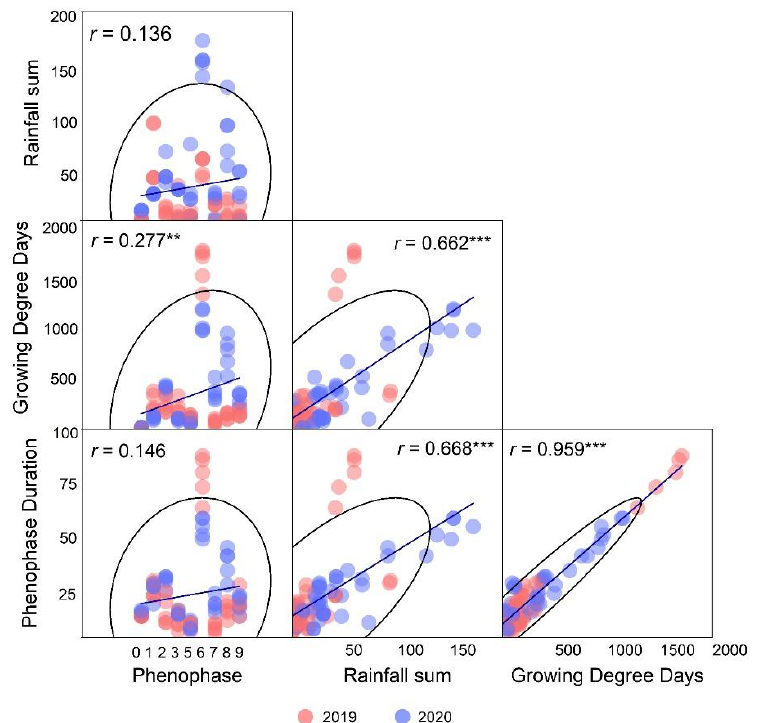
Figure 8. Scatter matrix for the experimental variables in Agastache ; ellipse represents 95% confidence interval (CI); Pearson correlation significant at p 0.01 (**) and p 0.001 (***). The linear fitting model further confirmed that phenophase duration was to a great extent influenced by GDD (Figure 9).